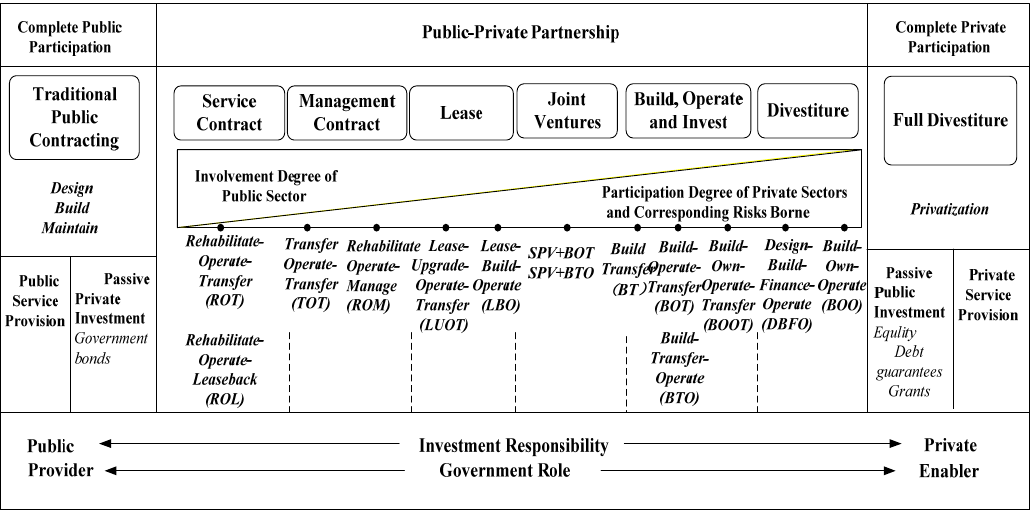
Figure 1. Forms of PPP and degrees of private involvement (De Jong et al.